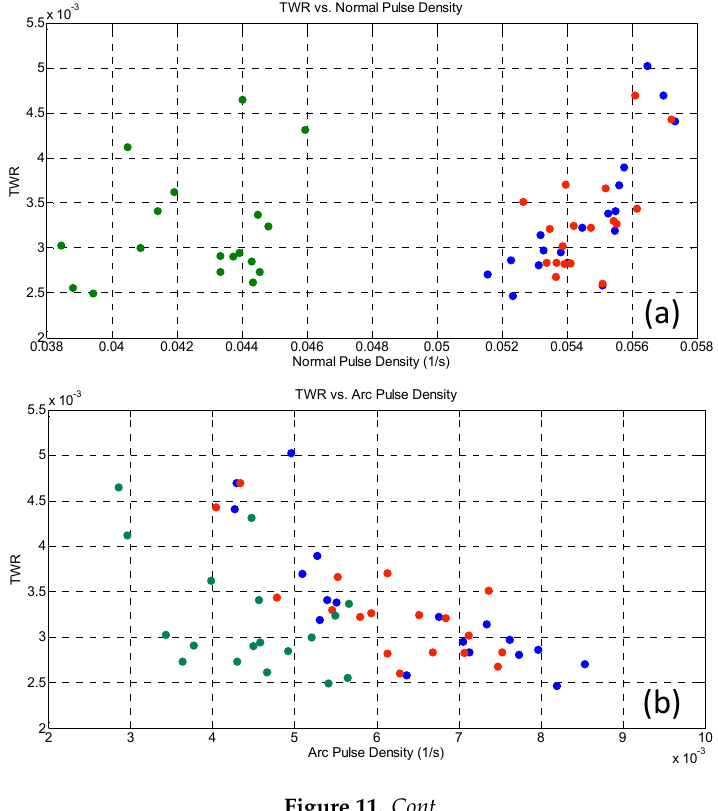
Figure 10. MRR versus ( a ) normal, ( b ) arc, and ( c ) delayed pulse density: blue dots refer to gap = 40, red dots to gap = 60, and green dots to gap = 80.